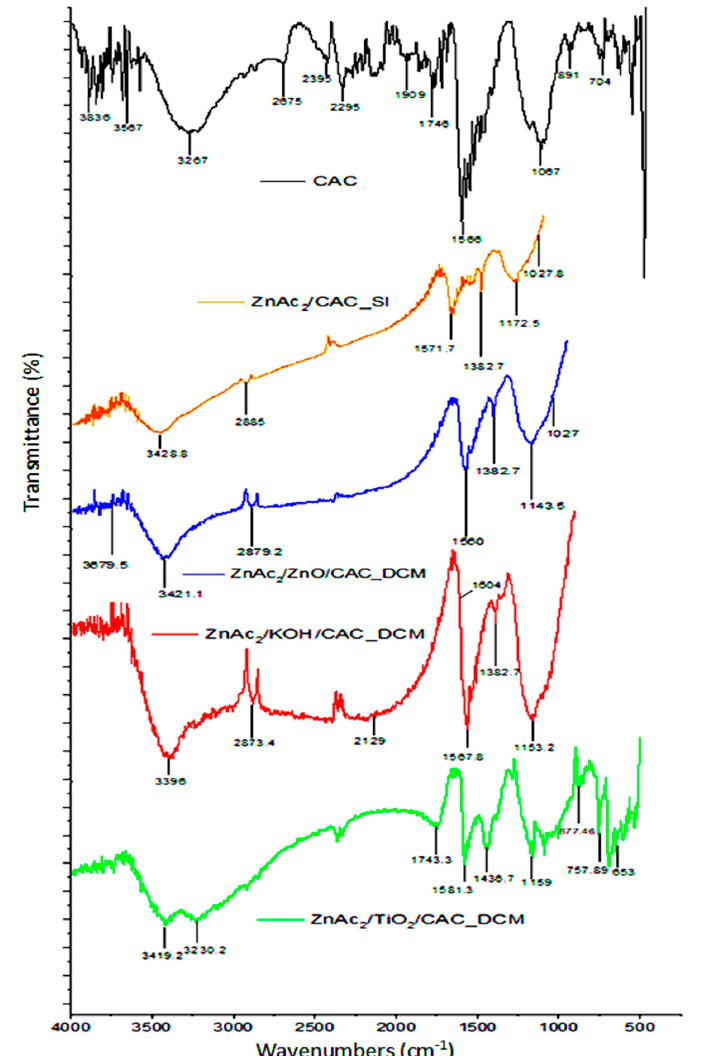
Figure 4. FTIR spectra for fresh DCM/CAC, SI/CAC, and raw CAC adsorbents. The wavelength spectra at 900 cm − 1 and 1231 cm − 1 indicate the presence of alkenes (C-H bond) and carbonyl (C=O) groups for all types of adsorbents [57]. However, each adsorbent had a different functional group depending on the material applied to the acti- vated carbon. The presence of oxygen in the adsorbent was associated with chemicals such as ZnAc 2 , ZnO, TiO 2 , and KOH, which had peak differences that indicated that the group functions, such as carboxylic acid (O–H bond), ether (C-O-C stretch), hydroxyl (O–H), acid anhydride (RC (=O) OC (=O) R), and aromatic groups (formation of C=C ring), were at the peak wavelengths of about 1550 cm − 1 to 1200 cm − 1 , 1271 cm − 1 to 1224 cm − 1 , 3800 cm − 1 to 3200 cm − 1 , 1931 cm − 1 to 1618 cm − 1 , and 1550 cm − 1 to 1200 cm − 1 [58–60]. The carboxylic and hydroxyl groups that were found for the adsorbents were anticipated to increase the hy- drophilicity of the sorbents, which would be advantageous for H 2 S removal [43]. The impregnation of adsorbents with ZnAc 2 and other chemicals, such as ZnO, KOH, or TiO 2 , generally did not result in significant changes in the wavelengths and functional groups compared to the ZnAc 2 /CAC_SI samples. This phenomenon was due to the weak interaction between the dispersed metal oxide and its framework. Interestingly, evidence for the interaction between the phases of the metal associated with the CAC can be seen